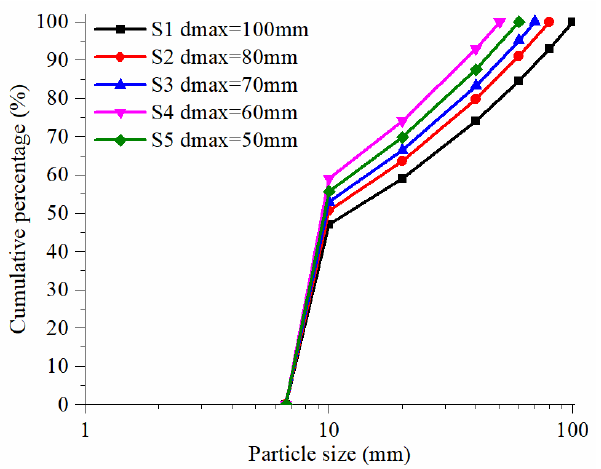
Figure 6. Modified particle distributions of SRM samples with different maximum particle diameters.